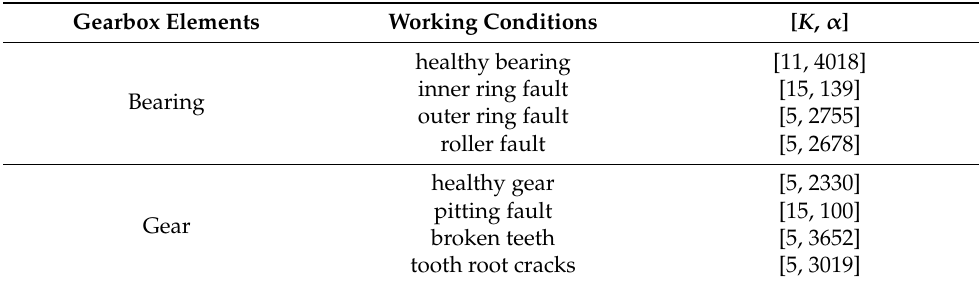
Table 11. Optimal values of [ K , α ] obtained by GWO in the eight working